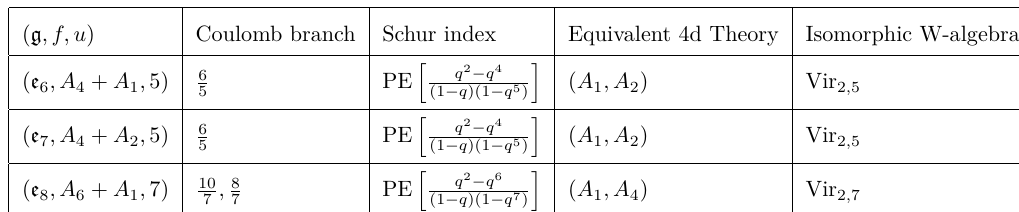
Table 10 . Theories without the Higgs branch but whose regular singularity has a flavor symmetry (mass deformation). f denotes the nilpotent orbit of the regular singularity, and u specifies the irregular singularity. The corresponding W algebra is W − h ∨ + h ∨